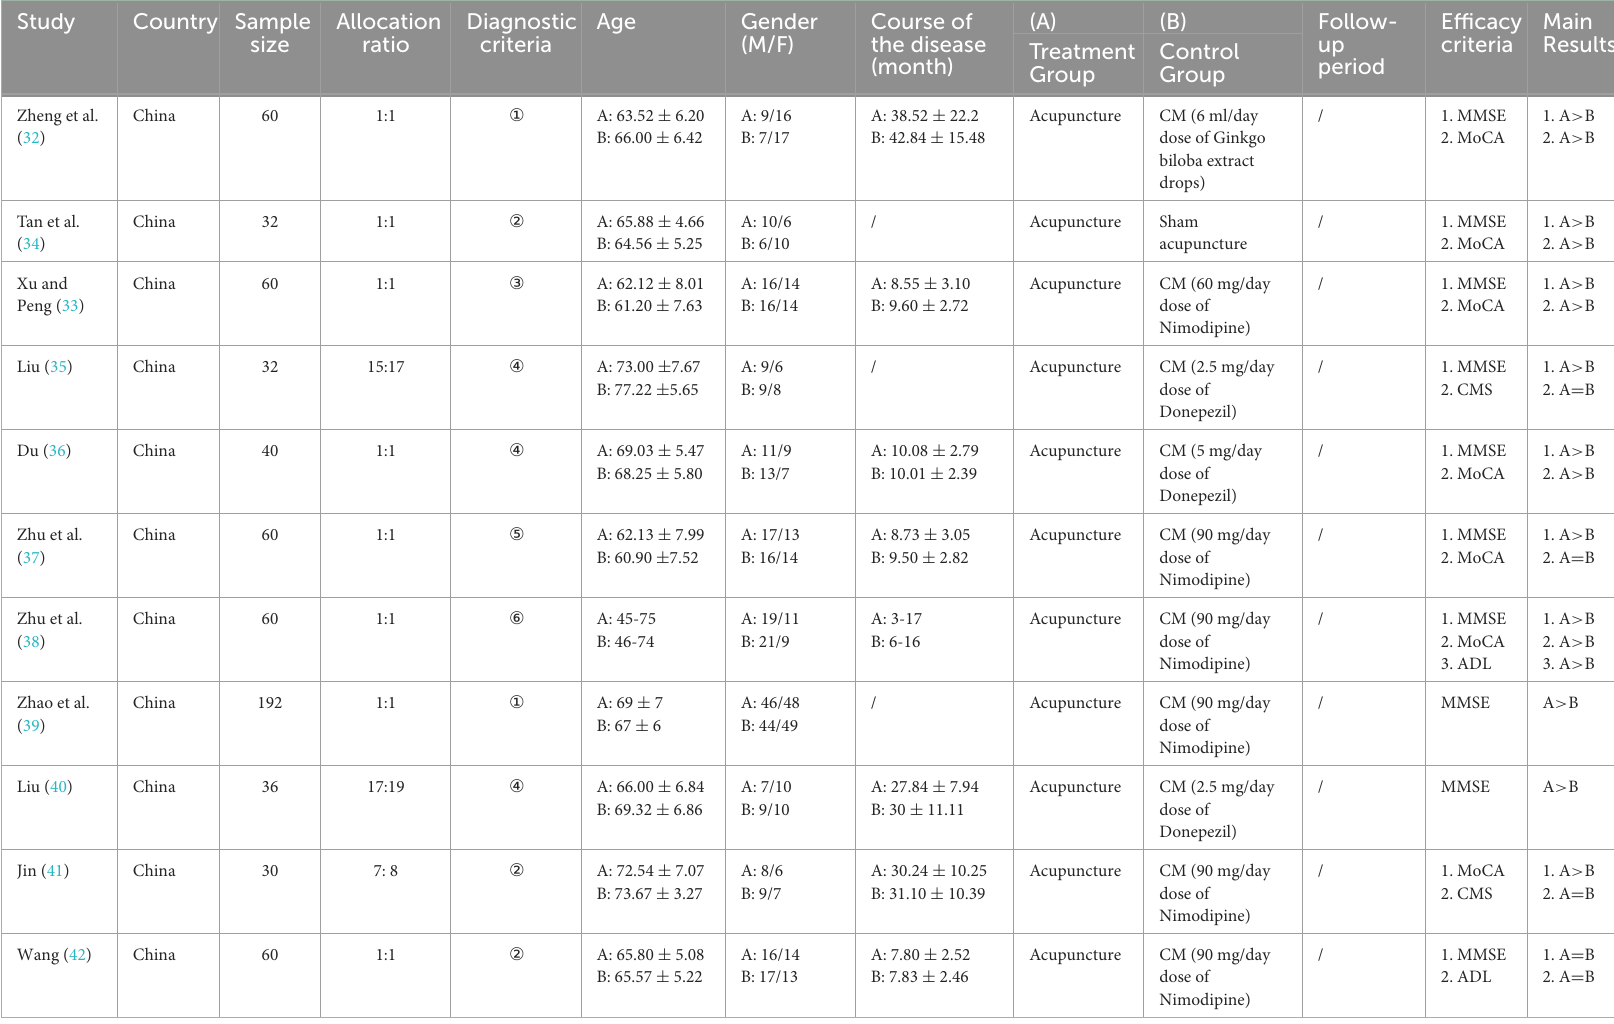
TABLE 1 Main characteristics of included randomized controlled trials